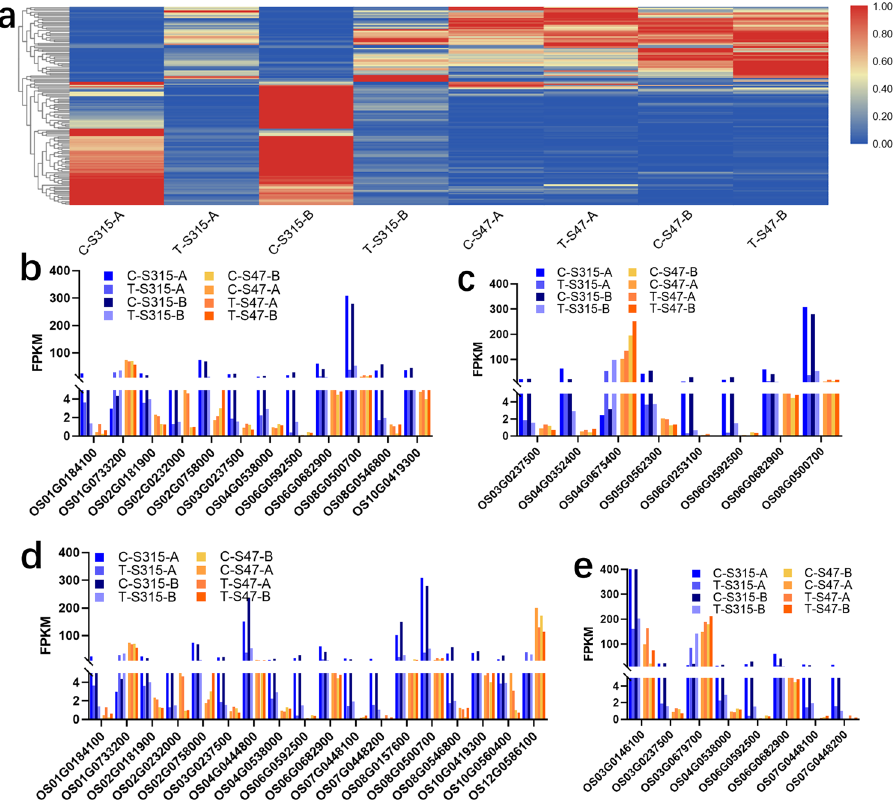
Figure 7. Enrichment analysis results of co-expressed DEGs between S315 and S47. ( a ) heatmap of all the co- expressed DEGs between S315 and S47. ( b to e ) expression of DEGs in these significantly enriched GO